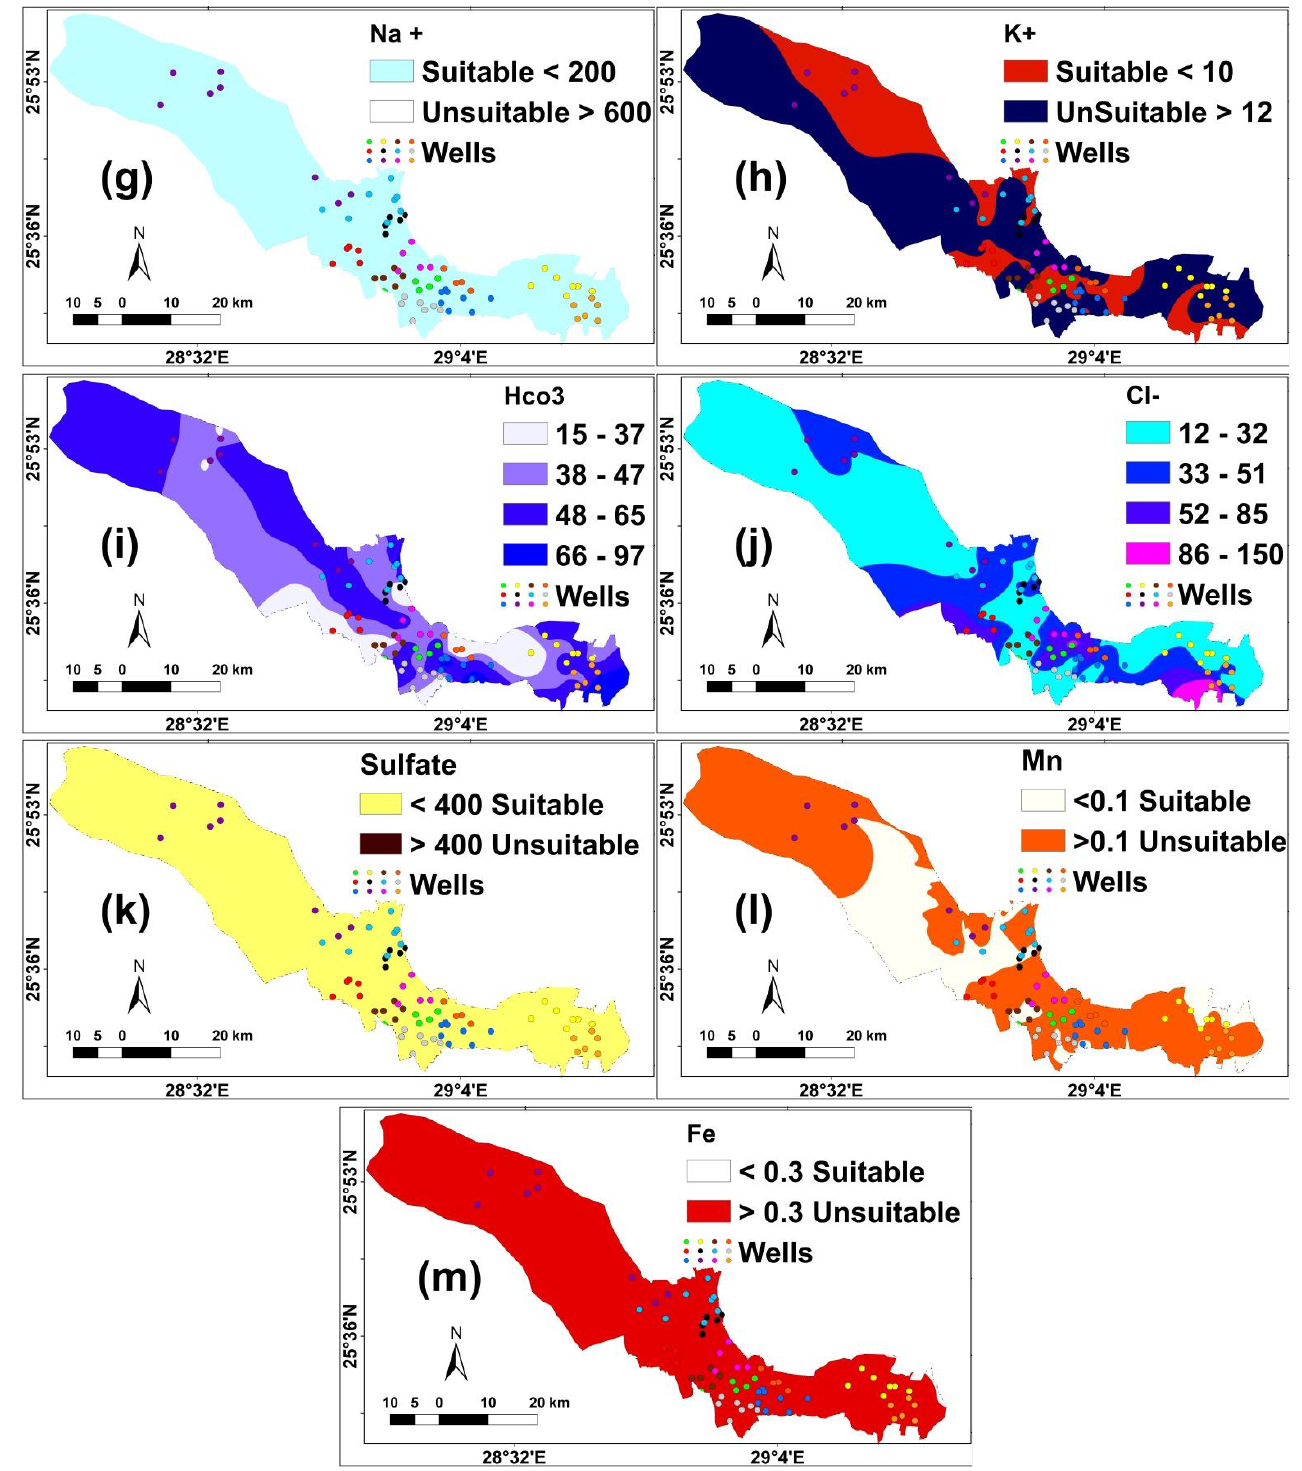
Figure 6. Spatial diversity in the appropriateness of groundwater characteristics for consumption according to WHO and Egyptian thresholds. ( a ); TDS, ( b ); TH, ( c ); EC, ( d ); pH, ( e ); Ca 2+ , ( f ); Mg 2+ , ( g ); Na+, ( h ); K + , ( i ); HCO 3 − , ( j ); Cl − , ( k ); SO 4 2 − , ( l ); Mn 2+ , and ( m ); Fe 2+ . To produce the map of groundwater compatibility for drinking in the studied region, we created a water quality spatial model (WQSM) (Figure 7). Each parameter is given a weight depending on its relative value for drinking purposes order, as shown in Table